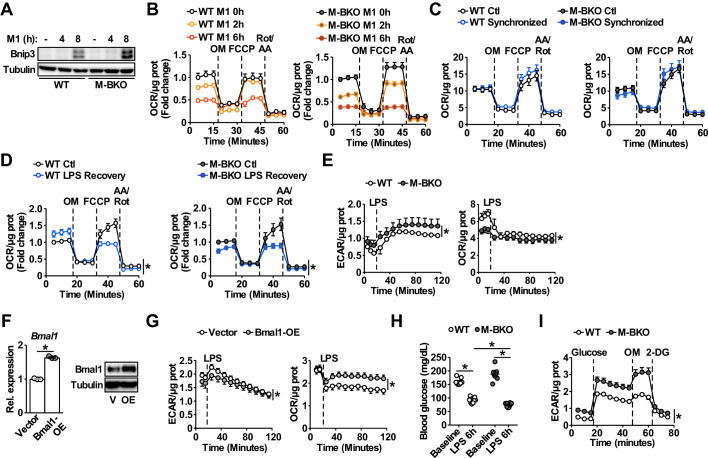
Effects of Bmal1 gene deletion and overexpression on glycolytic versus oxidative metabolism.(A) Immunoblot of the mitophagy regulator Bnip3 in M1-activated WT and M-BKO BMDMs. (B) Mitostress test measuring oxygen consumption rate (OCR) in Ifn-γ-primed macrophages pretreated without or with LPS (10 ng/mL) for 2 or 6 hr before the assay. Following three measurements of basal respiration, sequential injections of oligomycin (OM, 2 μM), carbonyl cyanide-4-phenylhydrazone (FCCP, 0.5, μM) and rotenone and antimycin A (rot/AA, 1 μM) were carried out to determine uncoupled respiration, spare respiratory capacity, and non-mitochondrial respiration, respectively. The assay medium contained minimal DMEM with 5 mM glucose and 1 mM sodium pyruvate, pH 7.4. N = 5 biological replicates. (C) Mitostress test measuring OCR in macrophages without (control, Ctl) or with serum shock resulting from treatment with 50% FBS for 2 hr to synchronize the circadian clock (Synchronized). Cells were recovered in fresh growth medium containing 10% FBS and the assay was performed 16 hr after the serum shock treatment. N = 5 biological replicates. (D) Mitostress test measuring OCR in macrophages without or with acute LPS treatment. Cells were cultured in growth medium with 2% FBS without (Ctl) or with 100 ng/mL LPS for 2 hr (LPS recovery), followed by recovery in fresh growth medium with 2% FBS for 24 hr prior to the assay. N = 5 biological replicates, statistical analysis was performed using two-way ANOVA for Ctl vs LPS recovery across the time course. (E) Extracellular flux analysis of thioglycollate-elicited peritoneal macrophages measuring the changes in ECAR (left panel) and OCR (right panel) following LPS injection (final concentration 1 μg/mL). The assay medium contained 5 mM glucose and 1 mM pyruvate in minimal DMEM with 2% dialyzed FBS, pH 7.4. N = 5 biological replicates, statistical analysis was performed using two-way ANOVA for WT vs M-BKO across the time course. (F) Bmal1 mRNA expression determined by qPCR (left) and protein levels (right) in RAW264.7 macrophage stable lines. Bmal1-OE, Bmal1 overexpressing stable line. Cells that were transduced with empty vector were used as the control. N = 3 biological replicates for qPCR, statistical analysis was performed using Student’s T test. V, vector control; OE, Bmal1 overexpression. (G) Measurement of the changes in ECAR (left) and OCR (right) in Ifn-γ-primed RAW264.7 stable lines after injection with LPS (final concentration 100 ng/mL). The assay medium contained 25 mM glucose and 1 mM pyruvate in minimal DMEM with 2% dialyzed FBS, pH 7.4. N = 5 biological replicates, statistical analysis was performed using two-way ANOVA for control vs Bmal1 OE across the time course. (H) Blood glucose levels in 4-month-old WT and M-BKO male mice before and 6 hr after i.p. injection with 10 μg LPS per g body weight. N = 10 mice, statistical analysis was performed using Student’s T test. (I) Glycolytic stress test in splenic macrophages isolated from mice in panel (D) that were sacrificed 6 hr after LPS injection. ECAR was measured before and after injection with glucose (25 mM). Maximal glycolytic rate was determined by injection of oligomycin (OM, 2 μM). Glycolysis-dependent ECAR was determined by injection of 2-deoxyglucose (2-DG, 50 mM). The assay medium contained minimal DMEM, pH 7.4. N = 10 biological replicates, statistical analysis was performed using two-way ANOVA for WT vs M-BKO across the time course. Data are presented as mean ± S.E.M. *, p<0.05. Experiments were repeated at least twice.